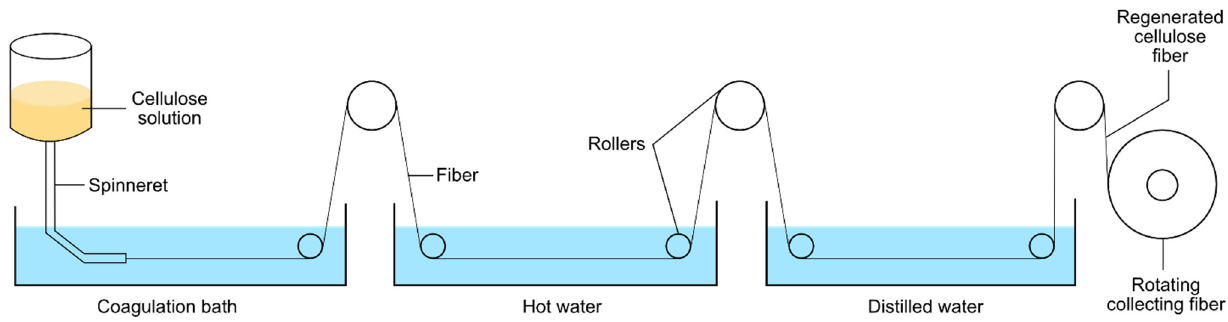
Figure 5. Schematic diagram of basic RC fiber processing.